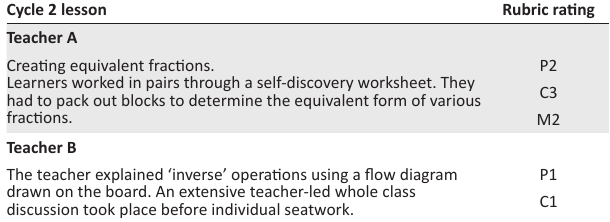
TABLE 2: Summary of Cycle 2